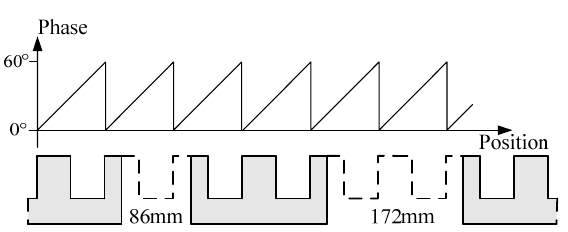
Figure 6. Phase waveform requirement near joint gaps.